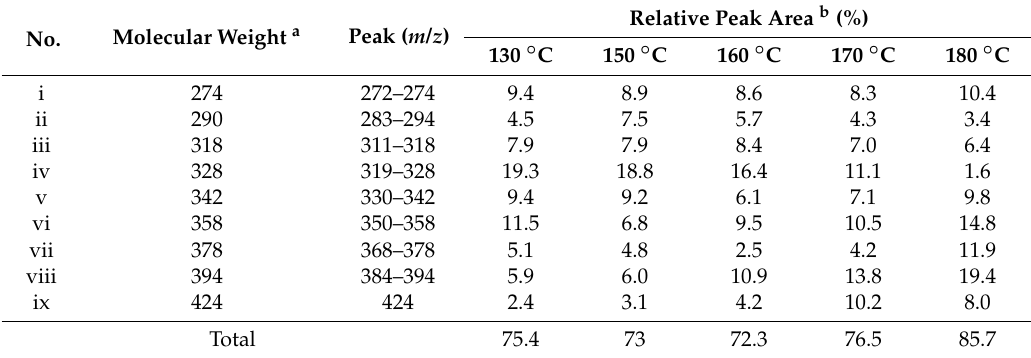
Table 2. Distribution of the aromatic oligomers identified by MALDI-TOF MS from lignin degradation under different reaction temperatures with the reaction time of 30